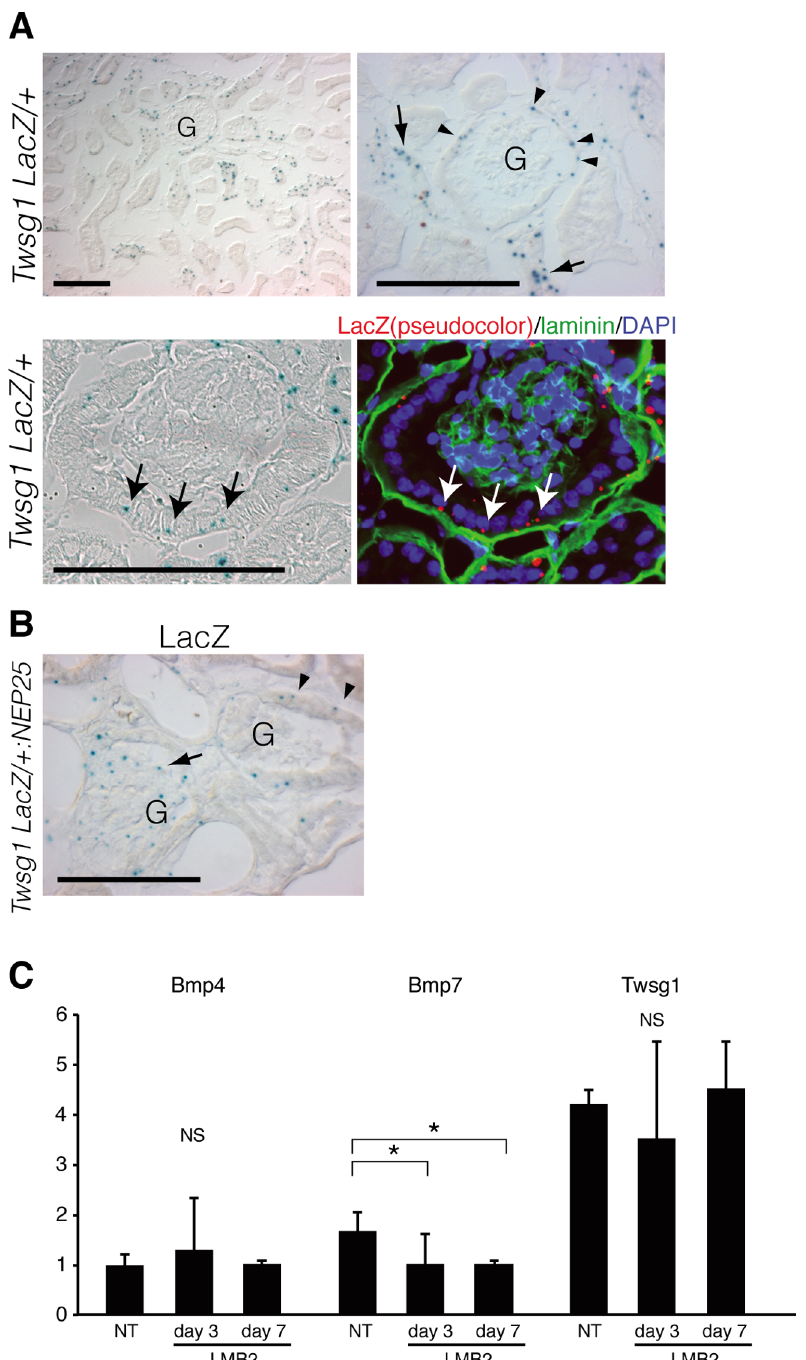
Figure 3. Localization of Twsg1 in healthy and diseased kidney. (A, upper row) X-gal staining of the kidney of Twsg1 + /LacZ mice. Twsg1 was expressed in glomerular parietal cells (PECs)(arrowheads), and distal nephrons (arrows). Twsg1 expression was not observed in podocytes of healthy kidneys. G: glomeruli. (A, lower row) X-gal staining and laminin immunostaining to show the expression of Twsg1 in PECs (arrows). Scale bars: 100 m m. (B) X-gal staining of the kidney of Twsg1 + /LacZ :NEP25 mice treated with immunotoxin. LacZ staining emerged within glomerular cells of some glomeruli (arrows), whereas LacZ staining in other glomeruli was confined in PECs (arrowheads). Scale bars: 100 m m. (C) Glomerular RNA of NEP25 mice was collected before and after the administration of LMB2, and was analyzed for the relative expression of Bmp and Twsg1 by real-time PCR. (n=3) NT, non treat. Data are presented as means 6 SD. * p , 0.05; NS, no significant difference. doi:10.1371/journal.pone.0089135.g003 genes by real-time RT-PCR ( Figure 3C ). The expression of To quantitate the expression of Bmp4, Bmp7 and Twsg1 in glomeruli during this model, we collected glomeruli utilizing Bmp7 decreased significantly during this disease model, whereas magnetic beads method[38], and analyzed the expression of these the expression of Bmp4 did not. Although the localization of